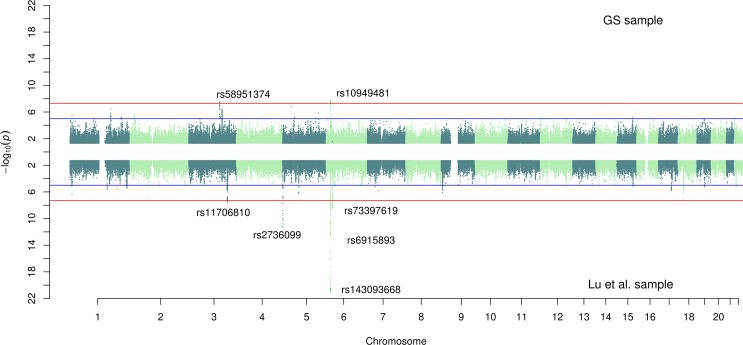
Miami plot for GWAS of Horvath-EAA in the GS and Lu et al. cohorts.SNP-based Miami plot comparing the results of genome-wide association analyses of Horvath-based epigenetic age acceleration in GS (top, n = 5,100) and Lu et al. (bottom, n = 8393), with—log10 transformed P-values for each SNP plotted against chromosomal location. The red line indicates the threshold for genome-wide significance (P<5×10−8) and the blue line for suggestive associations (P<1×10−5). Independent significant SNPs are annotated.